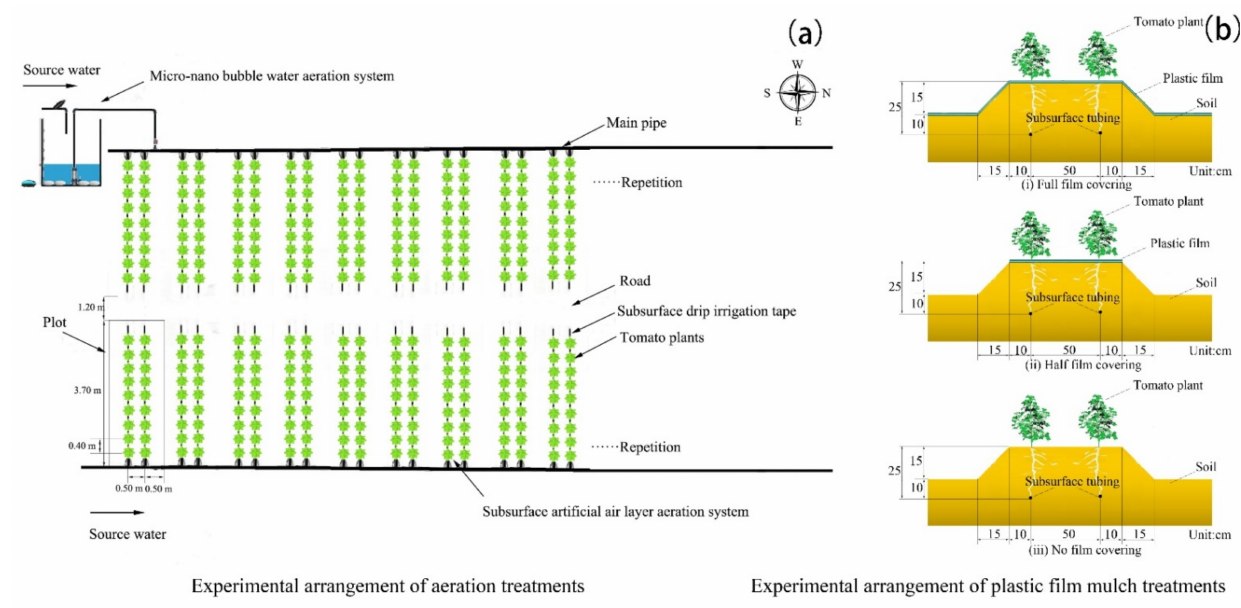
Figure A1. ( a ) Experimental arrangement of aeration and ( b ) plastic film mulch